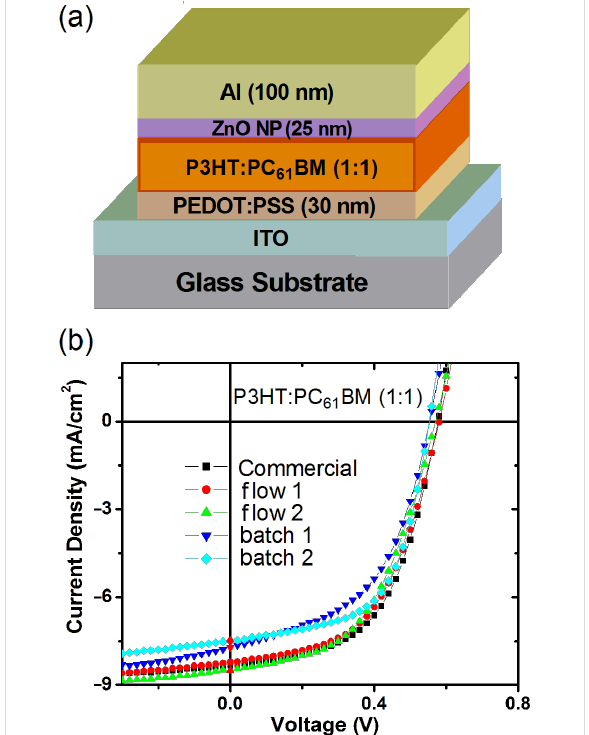
Figure 5: (a) Schematic diagram of the photovoltaic device geometry and (b) J – V curves of BHJ solar cells with P3HT:PC 61 BM active layer